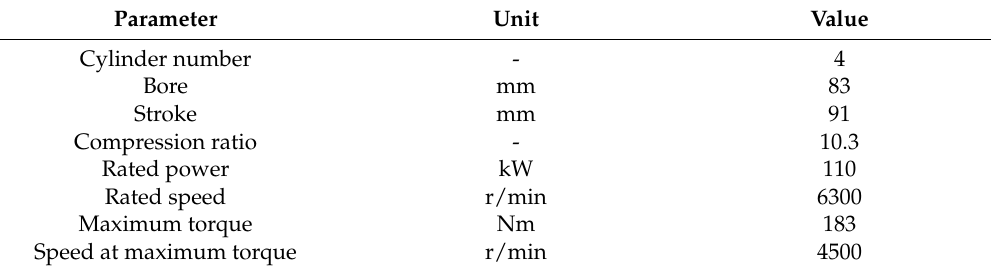
Table 2. Parameters of the 2.0 NA gasoline engine.